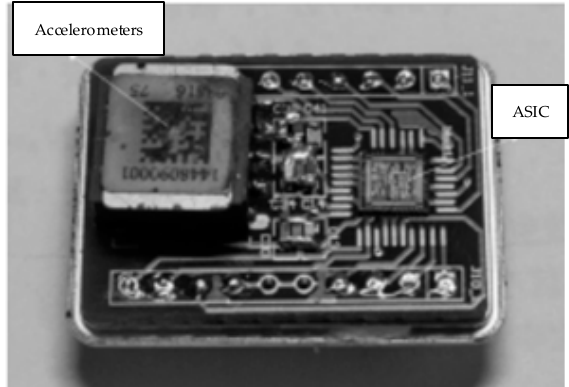
Figure 6. The picture of fabricated MEMS accelerometer and the packaged device.